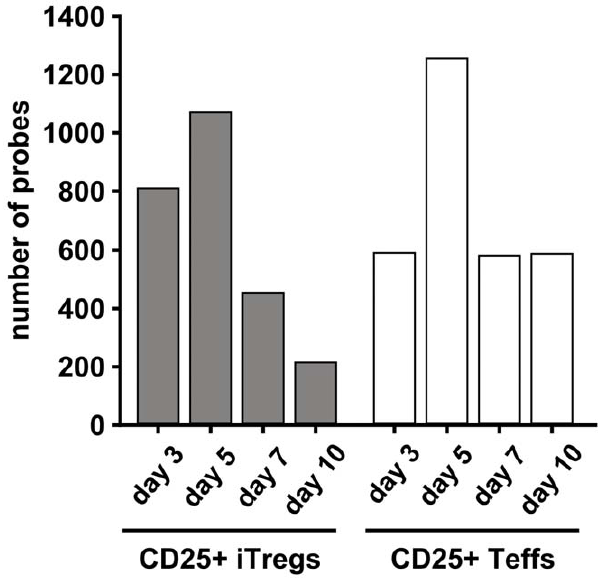
Figure 2. Number of regulated transcripts in CD25 + T cells during 10 days of culture. Bars indicate numbers of probes with at least two-fold differential expression between CD25 + iTregs or Teffs and their corresponding CD25- cell population at each analyzed time point.